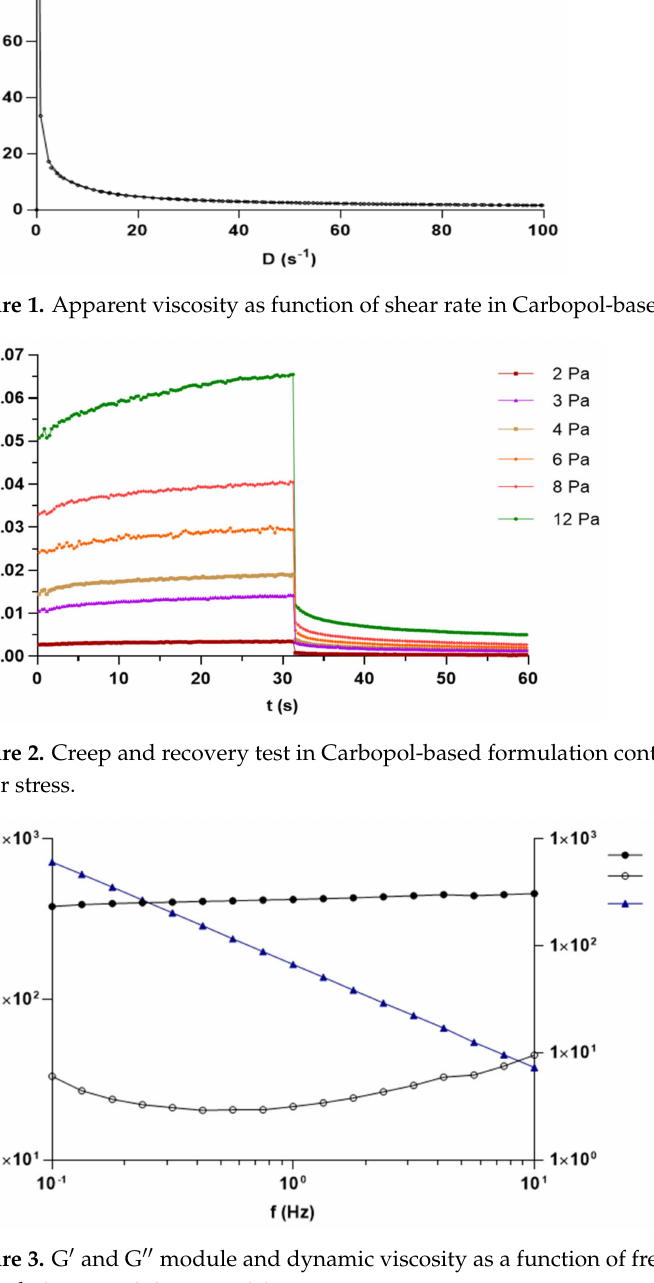
Figure 3. G (cid:48) and G (cid:48)(cid:48) module and dynamic viscosity as a function of frequencies in Carbopol-based formulation containing